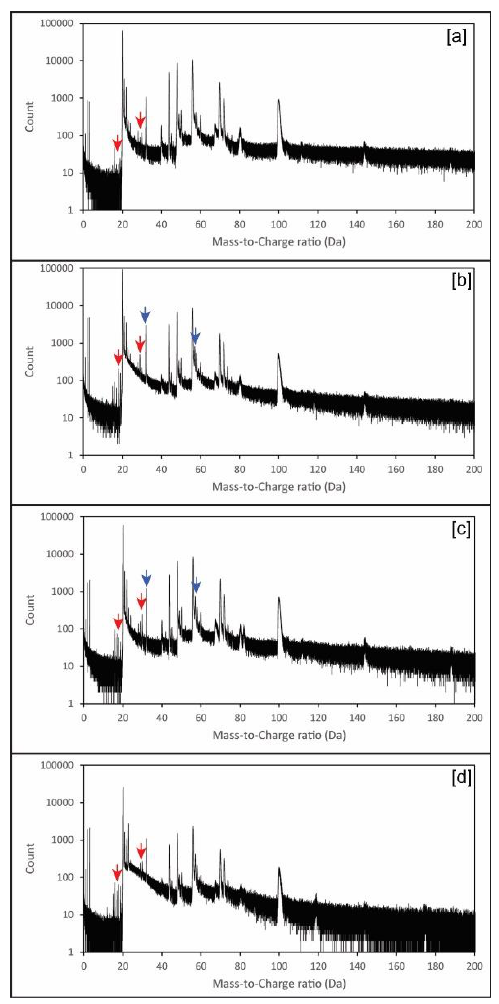
Figure 4. Example of representative APT mass spectra: ( a ) Calcite and chitin hydrogel; ( b ) Calcite and chitin at 0.12 mg / mL concentration of yatalase; ( c ) Calcite and chitin at 1.2 mg / mL concentration of yatalase; ( d ) Calcite and chitin nanofibers (Note: Red and blue arrows indicate some representative peaks indicative of chitin and yatalase, respectively; more details in Table 2). Detailed mass spectra with high resolution of peaks, identified in Table 2, can be found in Supplementary Figures